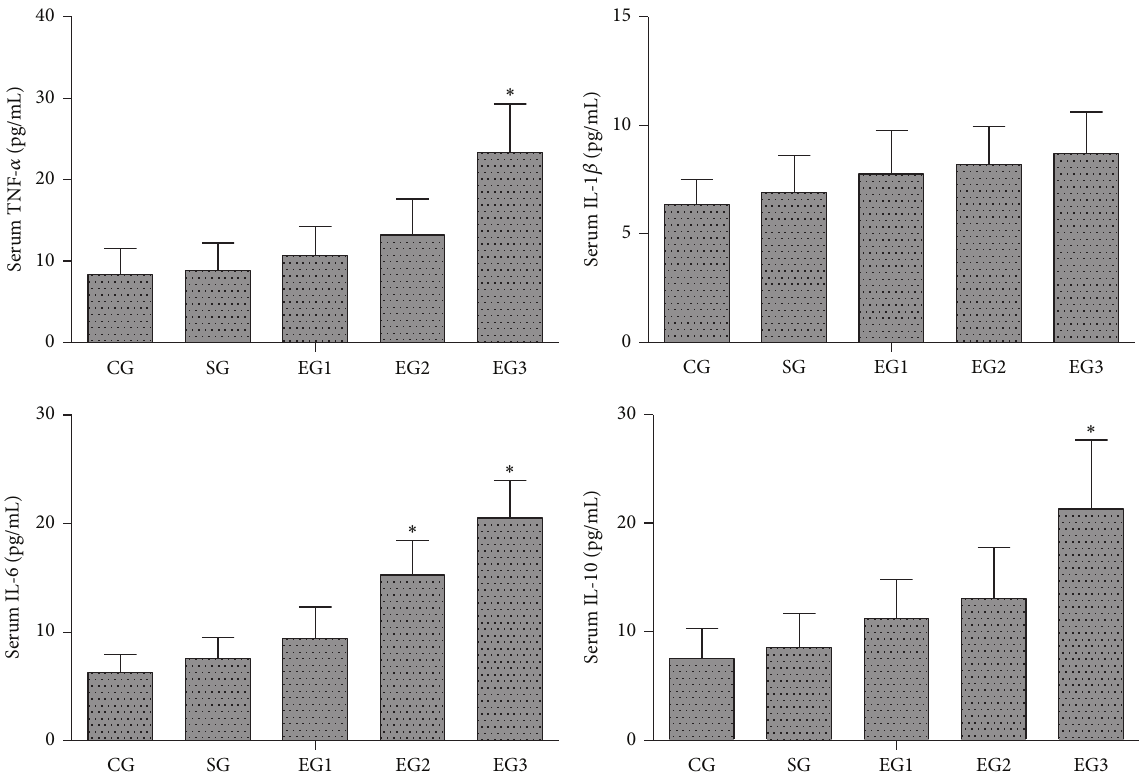
Figure 2: Serum concentrations of inflammatory cytokines TNF- 𝛼 , IL-1 𝛽 , IL-6, and IL-10 in each group. CG: control group; SG: sham group; EG1, EG2, and EG3: exposure groups with peritoneal air exposure for 1, 2, and 3 h, respectively. Data are expressed as mean ± SD, 𝑛 = 8 . ∗ 𝑃 < 0.05 , versus the CG